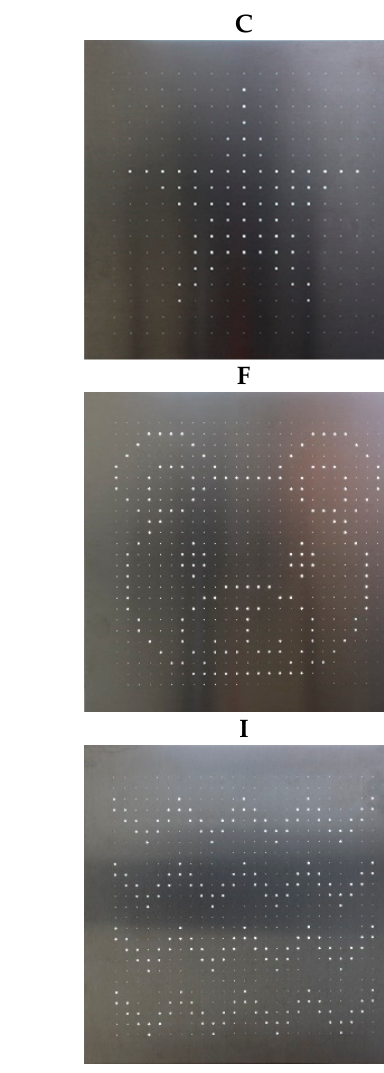
Figure 9. Photographs of specimens A–I. Table 5. Parameters of specimens A–I. Note that the larger hole is used for the pattern, and the smaller hole is used for the background *.